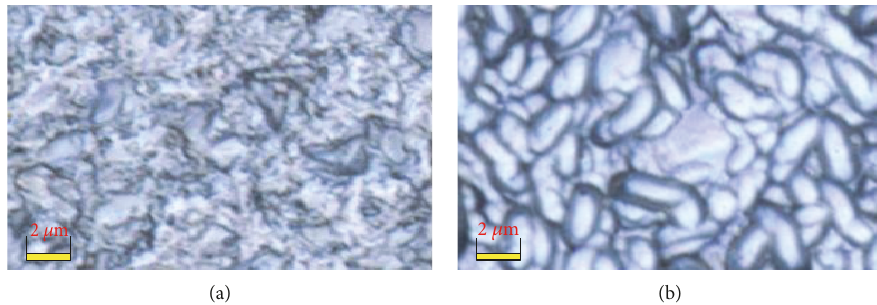
Figure 3: Plane-view optical microscope images of the surface morphologies (a) preetching and (b)